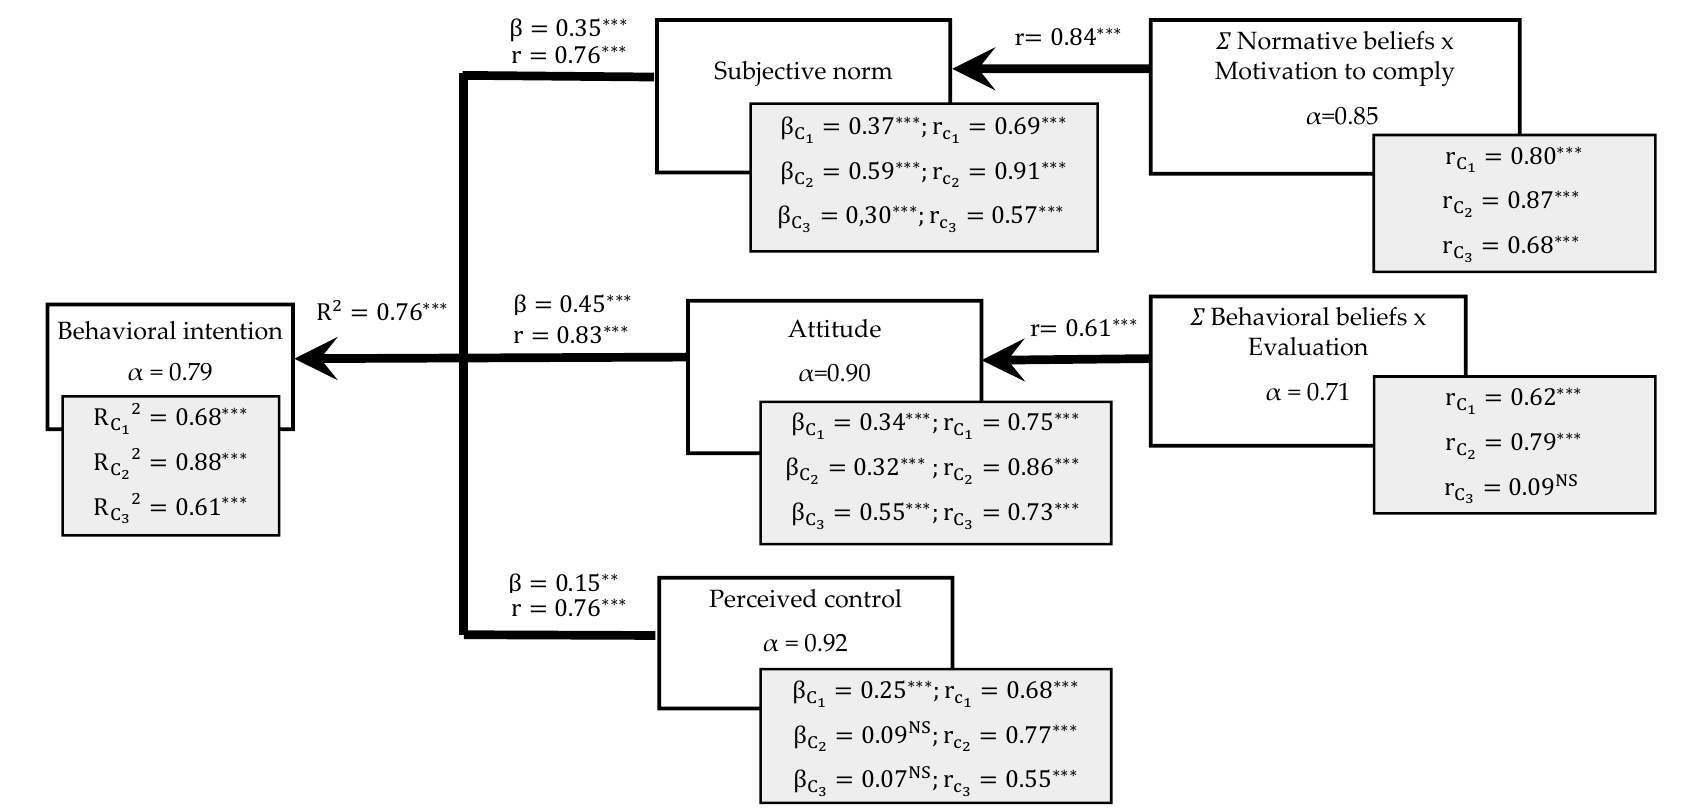
Figure 1. Final model of the theory of planned behavior for all the respondents ( N = 400) and for each cluster of participants. Significance: *** p ≤ 0.001; ** p ≤ 0.01; r: regression coefficient; R 2 : coefficient of determination; β : standardized regression coefficient; α : Cronbach’s alpha coefficient. NS: Not Significant.